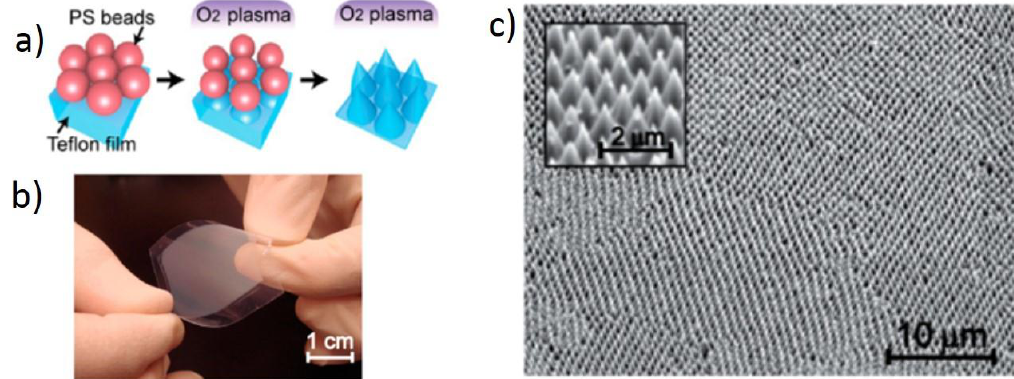
Figure 3. ( a ) Scheme of the fabrication process of Teflon nanocone arrays. ( b ) Photograph showing a macroscopic view of flexible Teflon nanocone array. ( c ) Scanning electron microscopy (SEM) images of the tilted nanocone array. Inset: detailed view of Teflon nanocones (Reproduced with